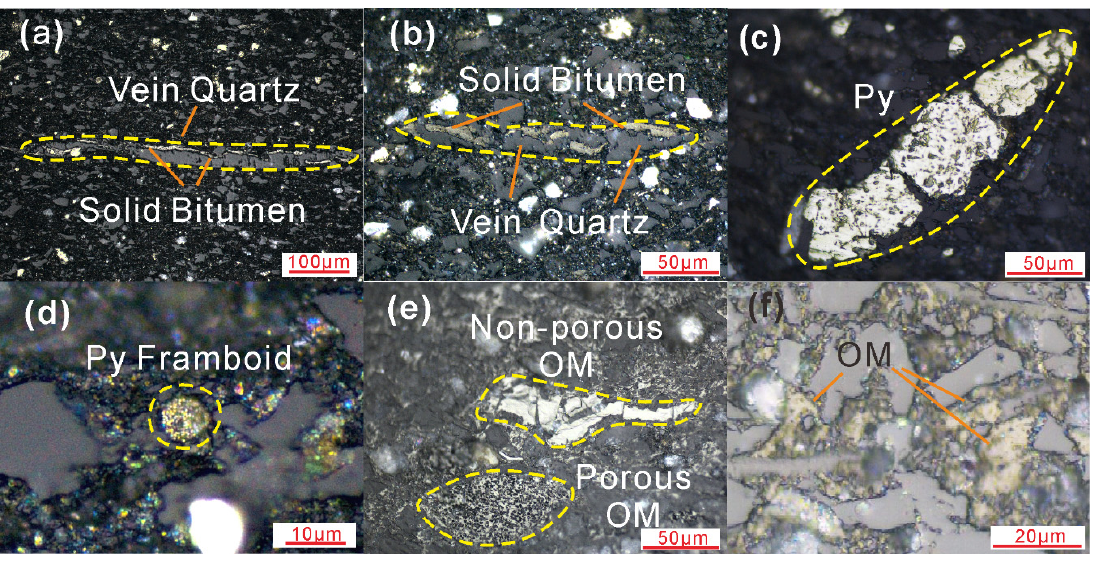
Figure 7. Reflected light microphotographs. ( a,b ) Vein quartz and elongated solid bitumen, both from N-6; ( c ) pyrites filling fossil cavities, N-3; ( d ) pyrite framboid, N-3. Py: pyrite; ( e ) organic matter aggregates with different pore features and size exceeding detrital grains, N-1. OM: organic matter; ( f ) isolated organic matter with size approaching to detrital grains, N-1.